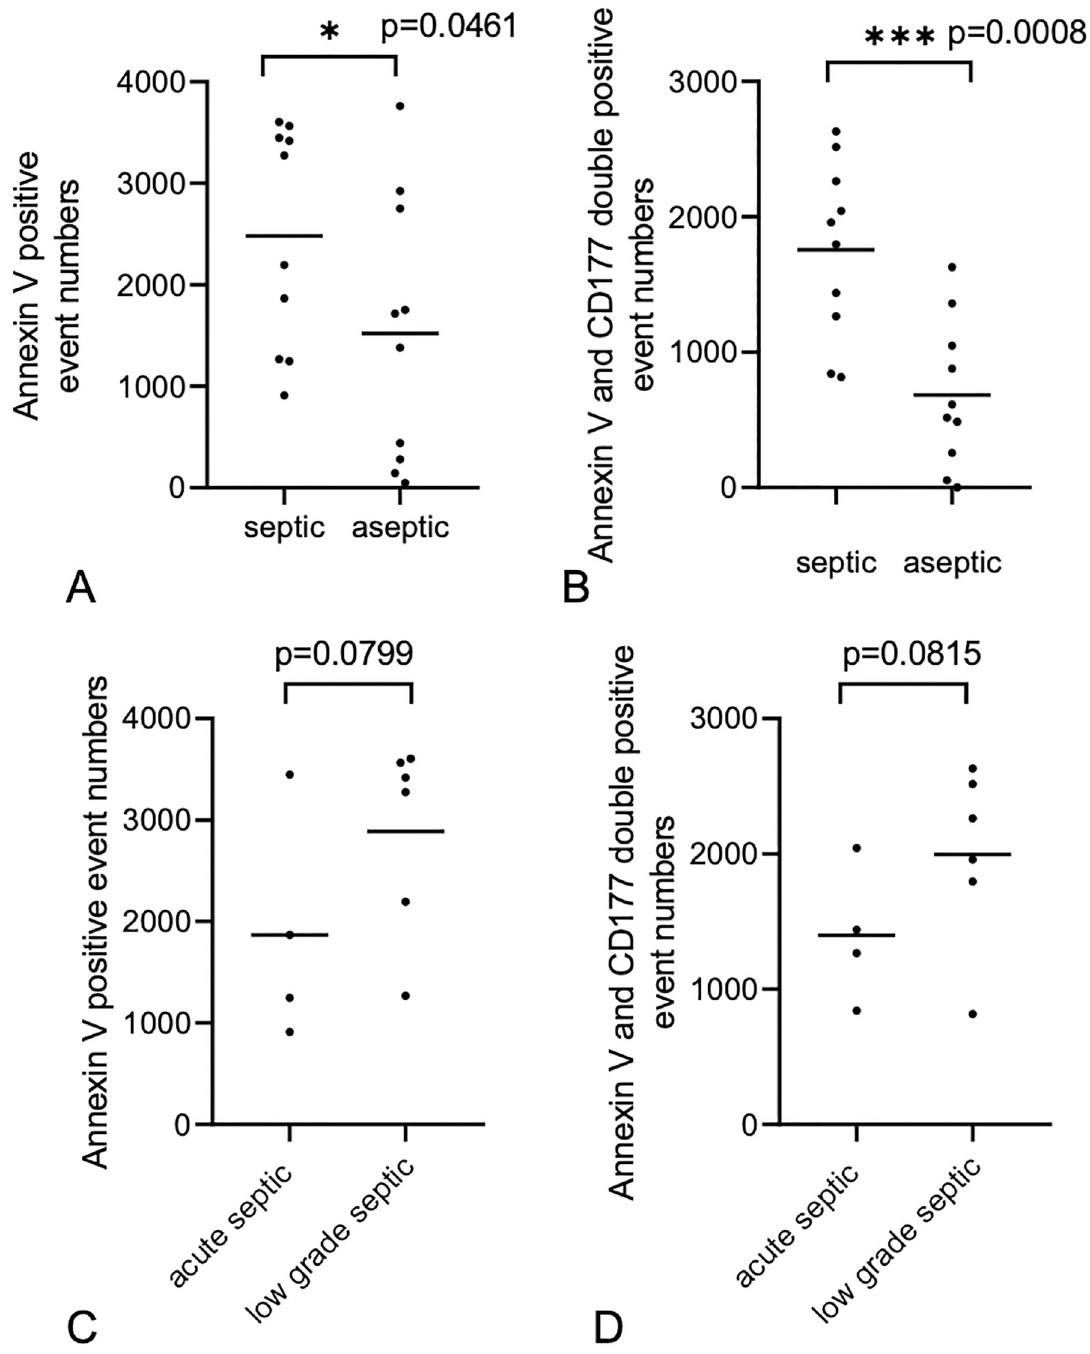
Fig 4. The Annexin V conjugated EVs event numbers were significantly higher in the septic group (p = 0.046, T-test) than is the aseptic group. The Annexin V and CD177 double stained event number was also significantly higher (p = 0.000809, T-test) in the septic than in the aseptic group (A-B). There was no significant difference between the acute and low-grade septic samples (C-D).